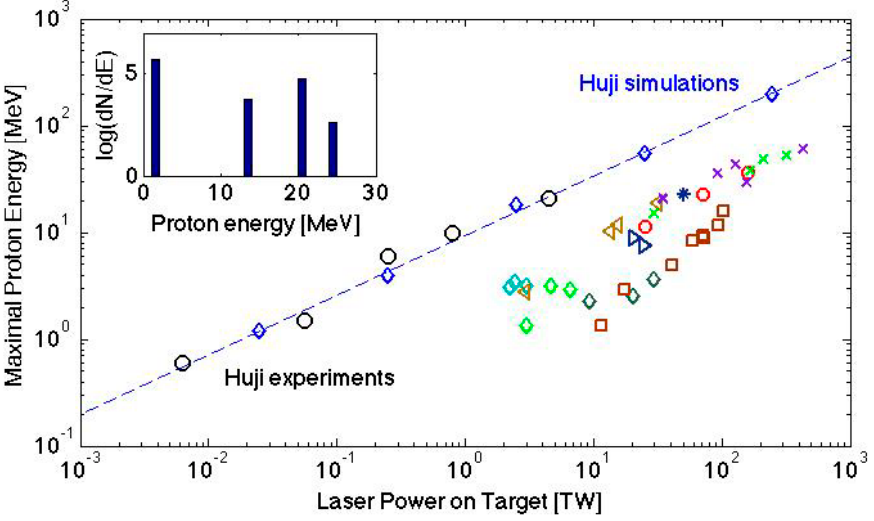
Figure 12. The dotted line shows the energy scaling of the accelerated protons as a function of the laser power on a snow target. All the other points below the line show the previous experimental results given in [59]. Reproduced from [59]. Copyright 2013, The American Physical